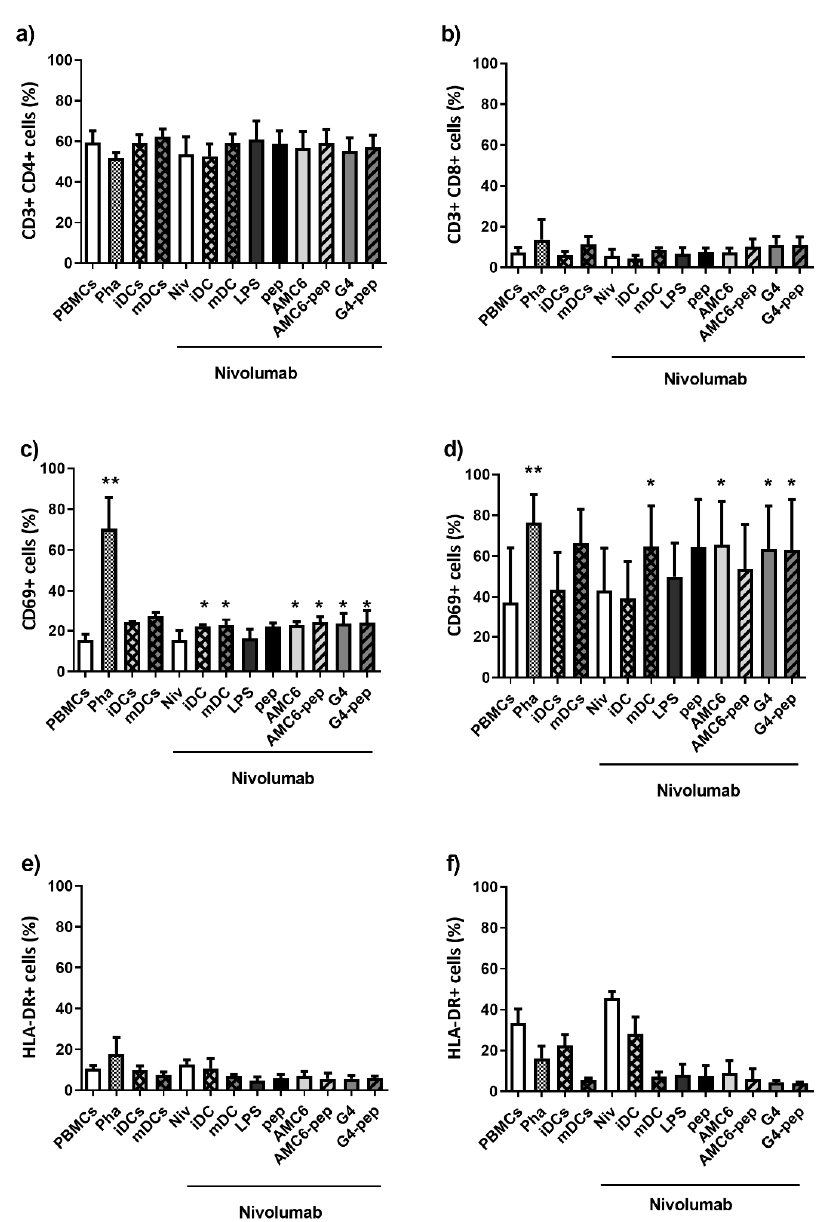
Figure 7. G4-70/30 (20 µM) dendrimer or AMC6 (3 µM) nanoparticle treated DCs cause small phenotypic alteration on CD4 + or CD8 + T cells after 5 days of co-culture. After co-culture of PBMCs with autologous DCs treated with the nanocompound-peptide complexes, the CD4 + and CD8 + T cell populations were analyzed by flow cytometry. These graphs show measurements of the population ( a , b ), and expression of CD69 early activation marker ( c , d ) and HLA-DR ( e , f ) on CD4+ ( a , c , e ) and CD8+ ( b , d , f ) T cells. Untreated PBMCs and PHA-activated PBMCs (Pha) were negative and positive controls respectively. PBMCs treated with iDCs and mDCs (without nivolumab) were also used as controls. All the other samples were treated with nivolumab. * p < 0.05; ** p < 0.01 as compared to PBMCs. Abbreviations: Pha = phytohemagglutinin, LPS-DCs = LPS matured DCs, pep = peptide,